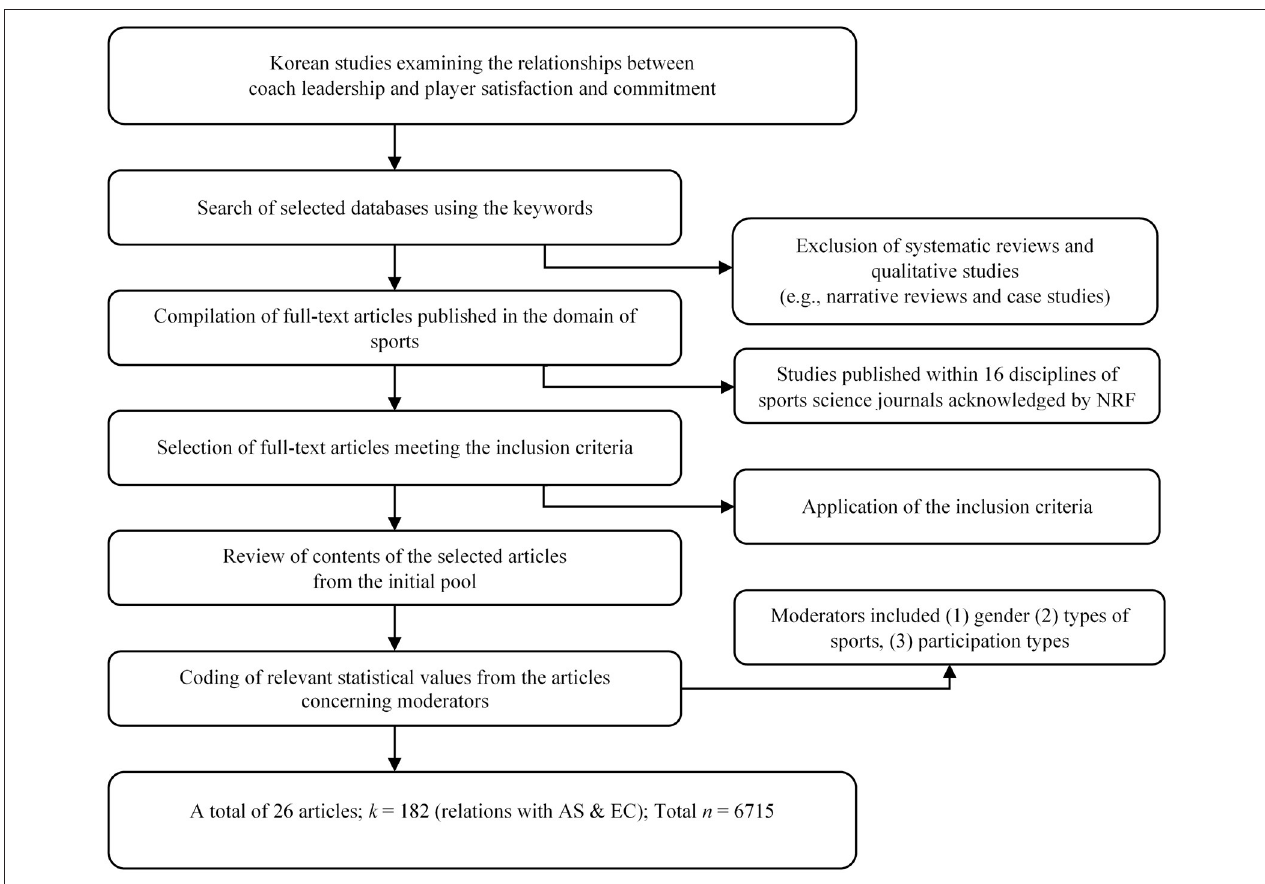
FIGURE 1 | Flow diagram of study selection